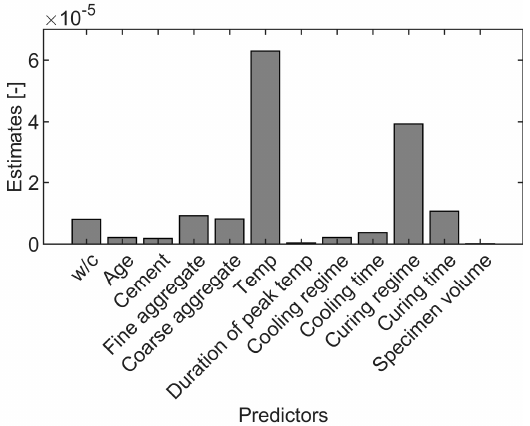
Figure 12. Feature importance results.